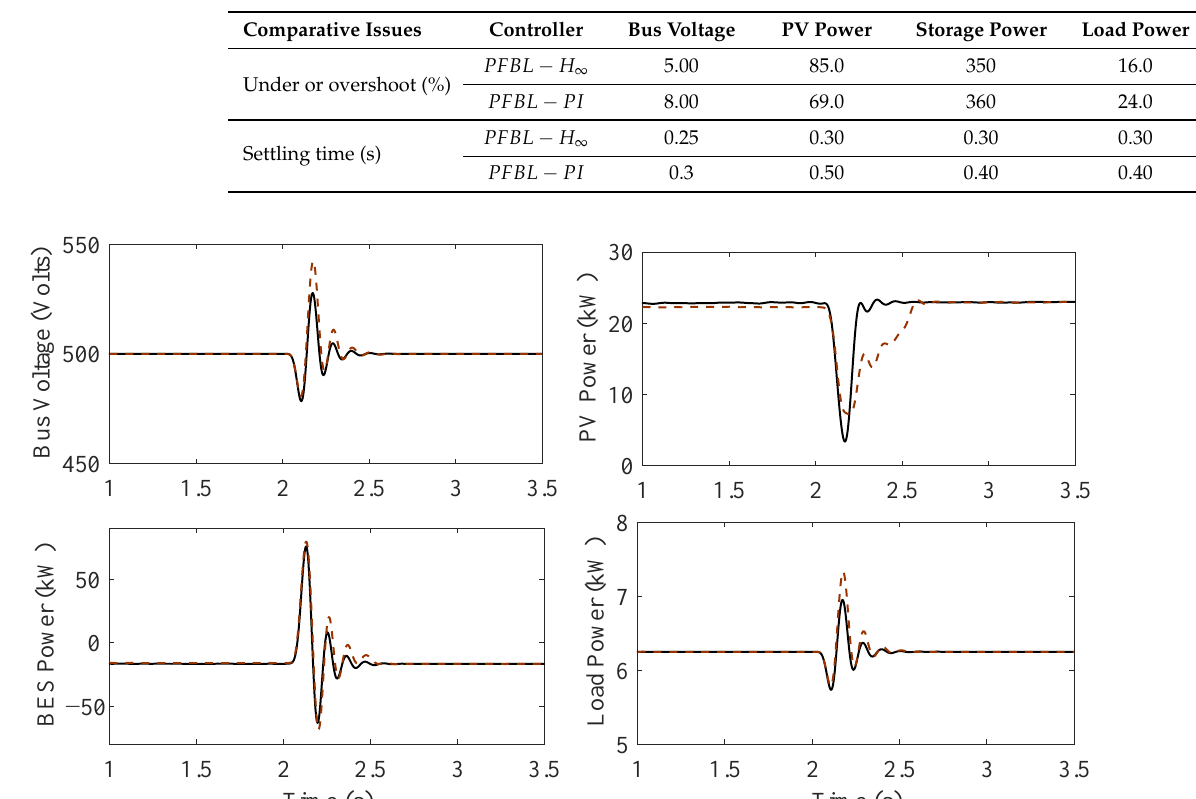
Table 4. Quantitative comparison between proposed and existing controller under parameter variation.